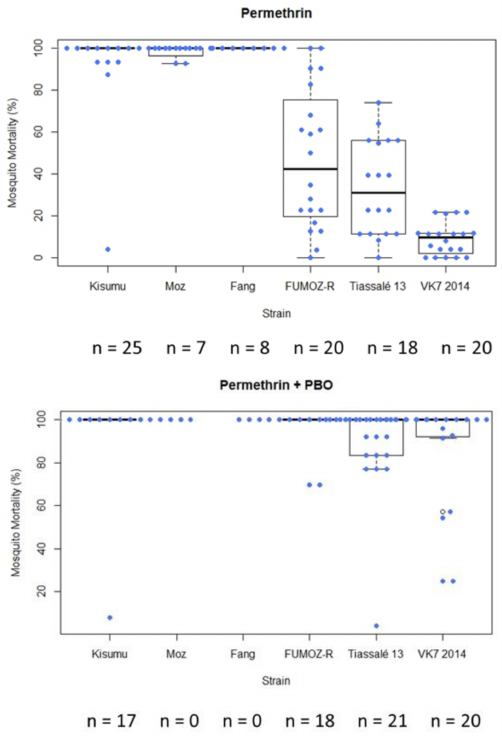
Figure 5. Box plot summarising mosquito mortality following exposure to permethrin 20 µ g /bottle ( top ), or permethrin 20 µ g/bottle + PBO ( bottom ) in a standard CDC bottle bioassay. Each box represents a different mosquito strain. Strains here are those maintained by LITE at LSTM. Coloured circles and n values indicate each replicate